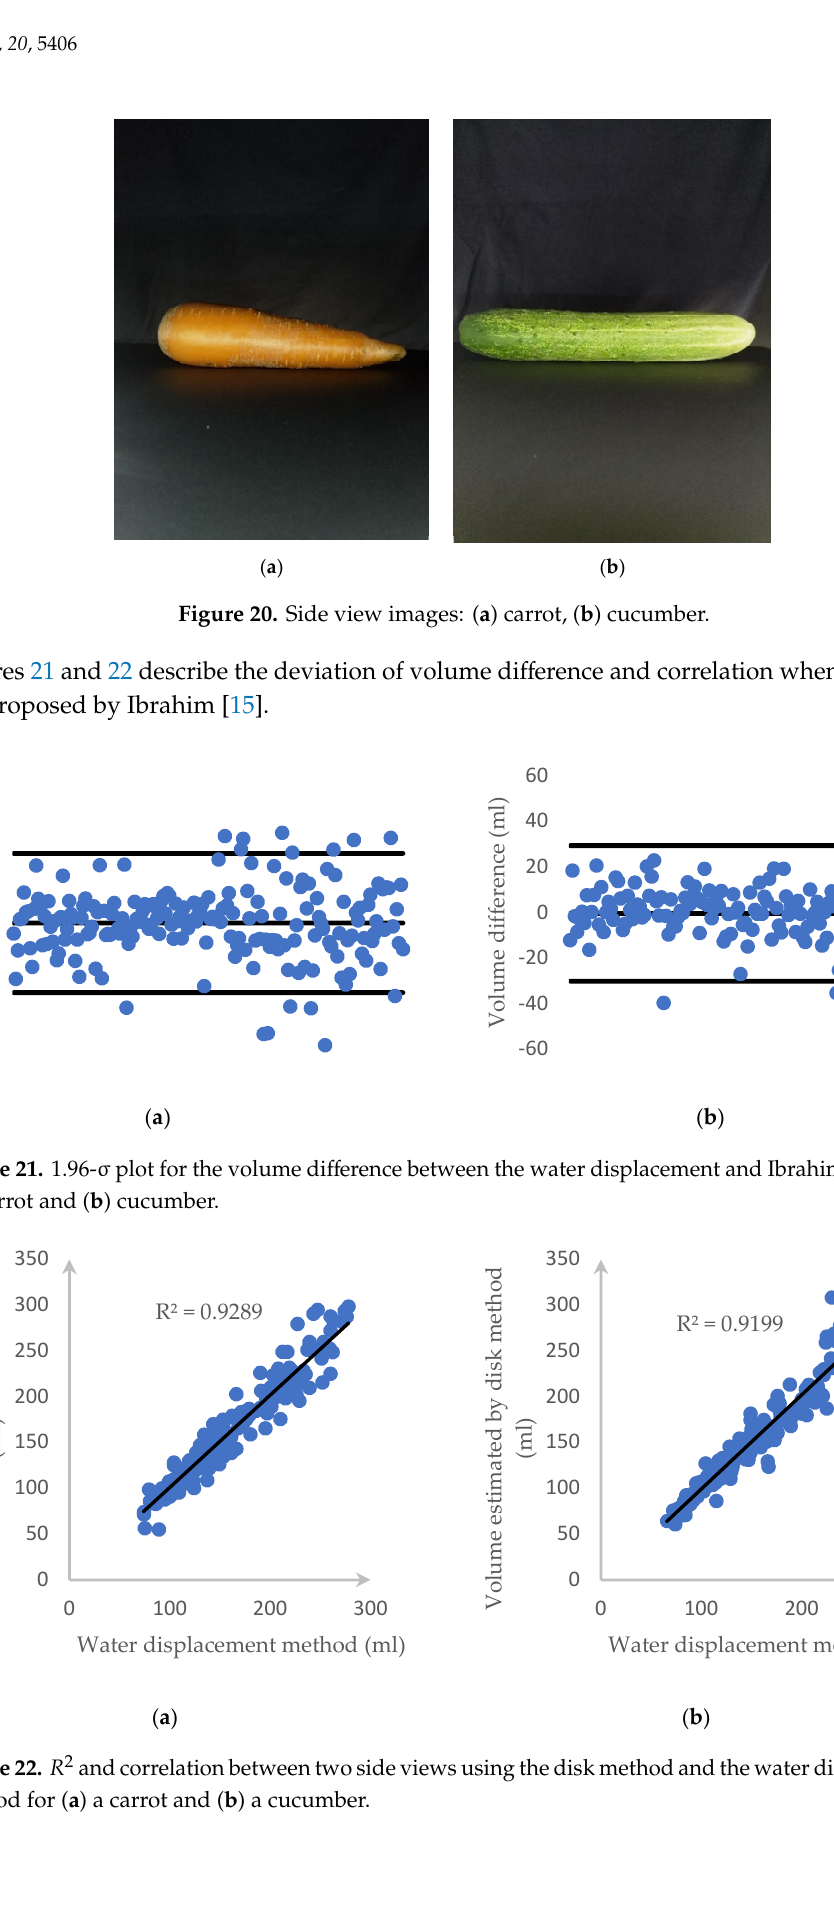
Figure 19. Top view images: ( a ) carrot, ( b ) cucumber.